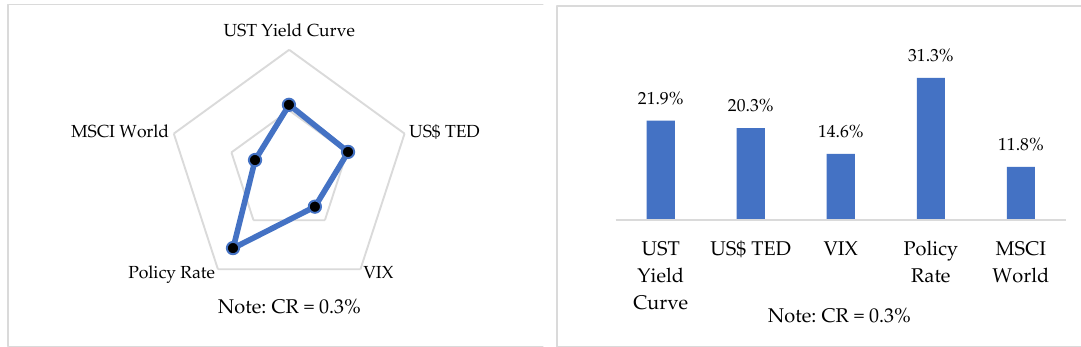
Figure 5. Local weights for international factors.